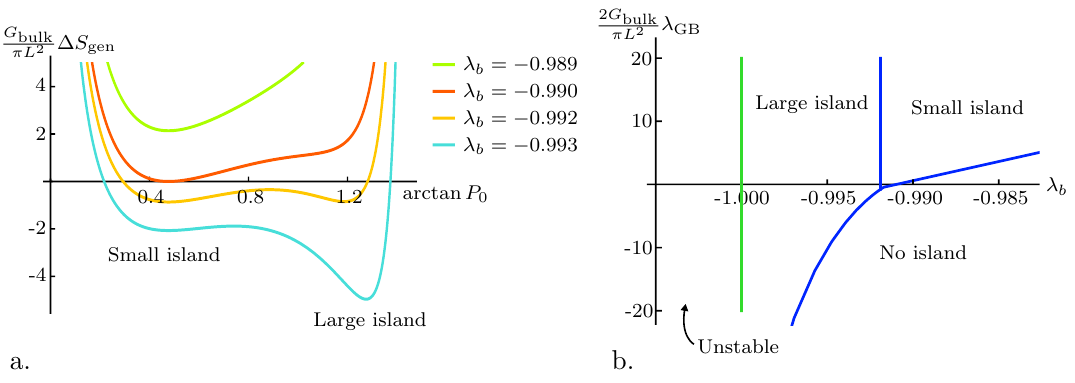
Figure 12 . Panel a.: generalised (renormalised) area from eq. (4.54) as function of P 0 , for di(cid:11)erent values of the DGP coupling (cid:21) b . Notice the appearance of a ‘large’ island when (cid:21) b approaches (cid:0) 1, due to the partial cancellation of the induced and DGP area terms. Panel b.: phase diagram: the black lines correspond to (cid:12)rst order phase transitions, while the blue one at (cid:21) b = (cid:0) 1 indicates the region where gravity becomes unstable. Both plots are done for (cid:12)xed L=z c) T 6 = 0; 1 =G 6 = o brane